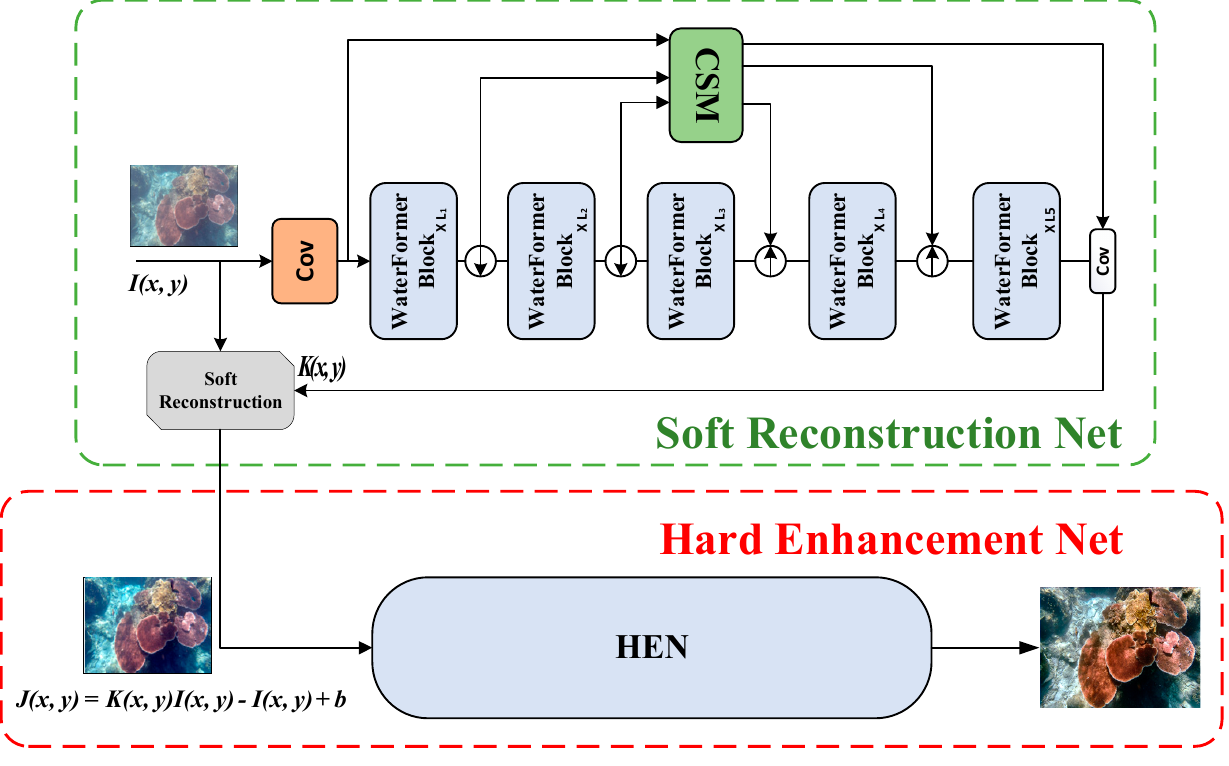
Figure 1. The overall structure of WaterFormer.